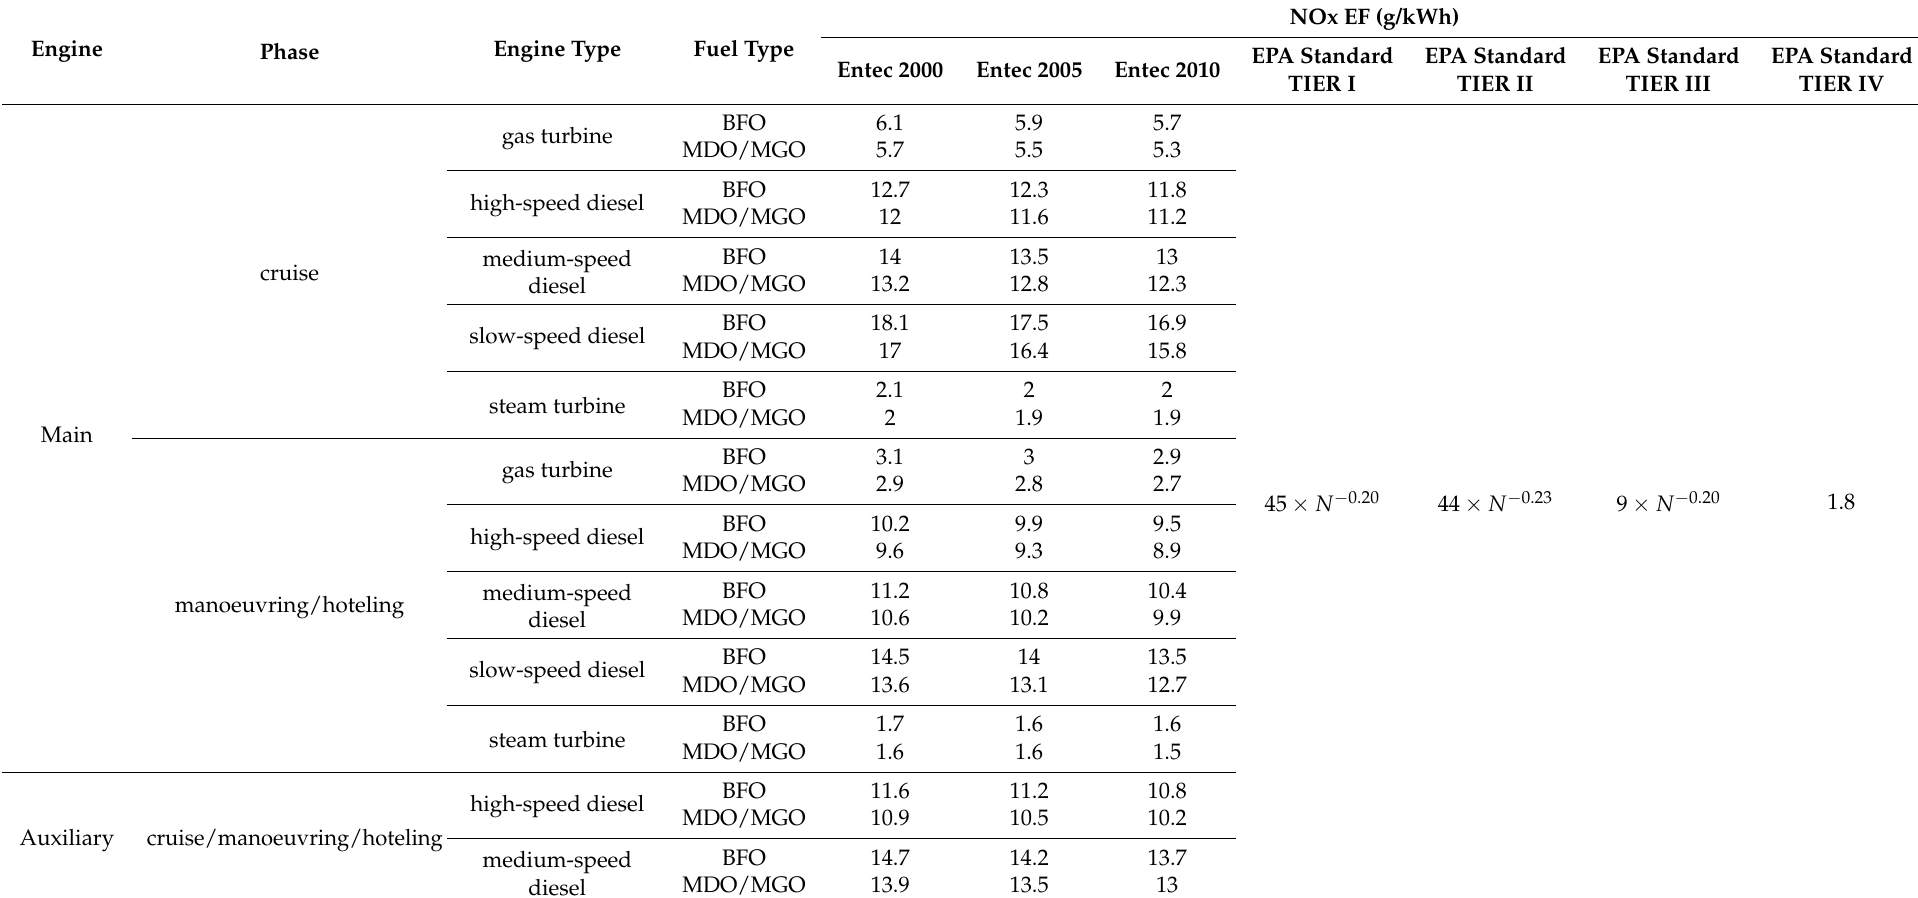
Table A2. Emission factors for NOx ( N = engine rpm)